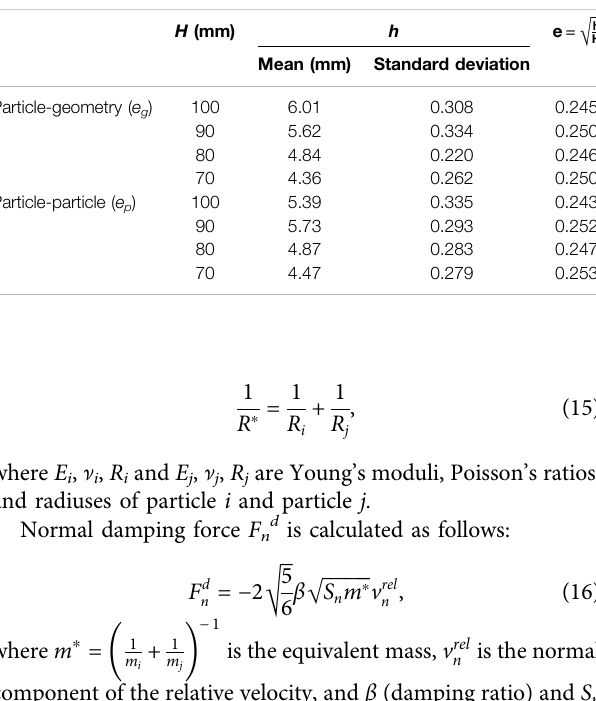
TABLE 2 | The restitution coef fi cient test results of B1 concrete. TABLE 3 | The rolling friction coef fi cient test results of B1